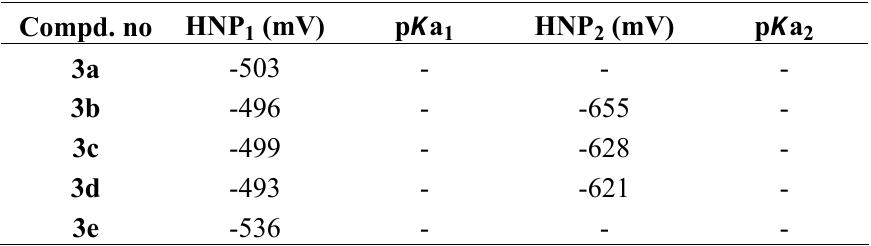
The half-neutralization potentials (HNP) and the corresponding p K compounds 3a-3e in N,N -dimethylformamide at 25